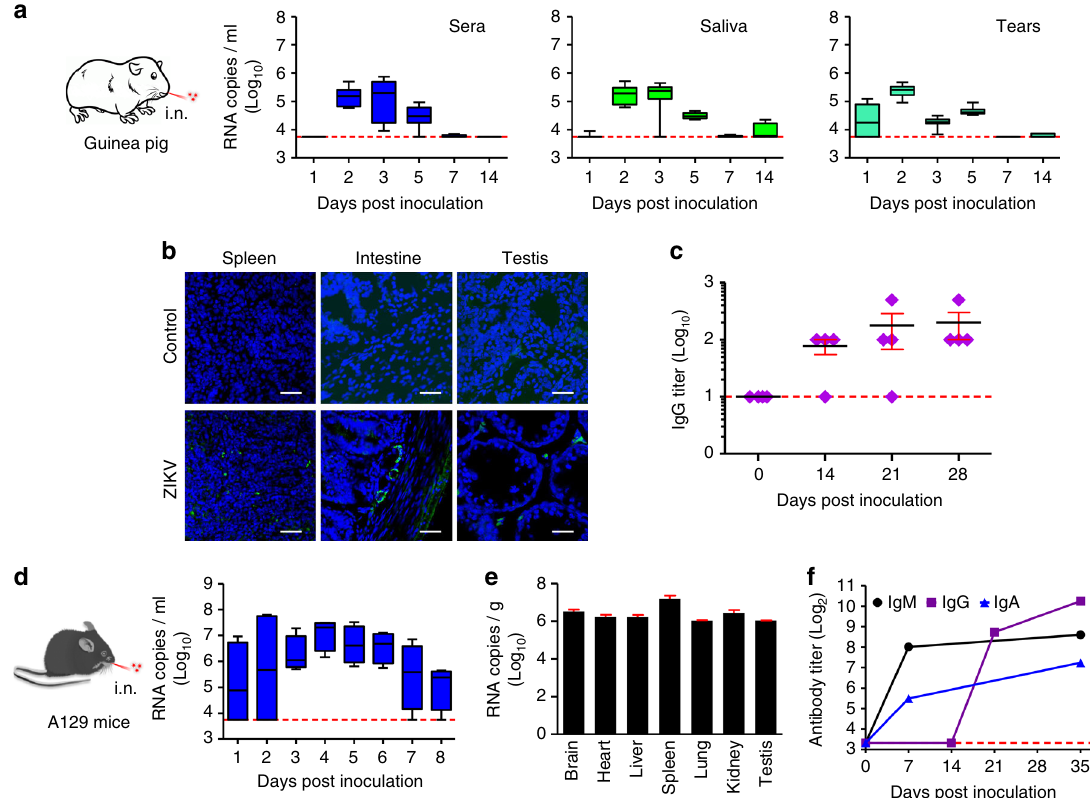
Fig. 3 Guinea pigs and A129 mice are susceptible to ZIKV infection via an i.n. route. a Sera, saliva, and tears samples of four ZIKV-inoculated guinea pigs ( n = 4) were collected following i.n. inoculation and analyzed as described above. b Immunostaining of indicated tissues were performed at 3 dpi. Scale bar: 50 μ m. c ZIKV E protein-speci fi c IgG antibody titers in guinea pigs ( n = 4) were measured using ELISA. IgG antibody titers were calculated according to the highest reciprocal dilution of serum to give an OD greater than the sum of the background OD plus 0.01 units. The data is shown in mean ± SEM. The dotted lines represent the limits of detection of the ELISA assigned values of 10. d Viremia of four ZIKV-inoculated A129 mice ( n = 4) at 1 to 7 days after i.n. inoculation was assessed. Dotted lines indicate the limit of detection. Whiskers: 5 – 95 percentile. e Tissue distribution of ZIKV RNAs in the i.n. inoculated A129 mice at 7 dpi. The data are shown as mean ± SD from two experimental replicates. f ZIKV E-speci fi c IgA, IgM, and IgG antibody titers were measured using ELISA. The dotted lines represent the limits of detection of the ELISA assigned values of